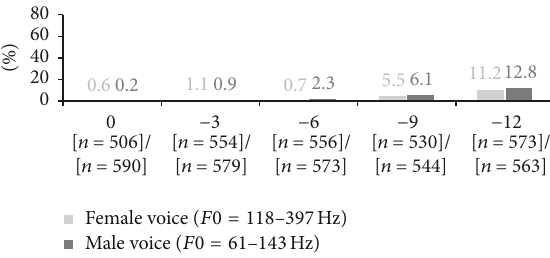
(1%–3%) was observed for these phonograms: 26 substitutes